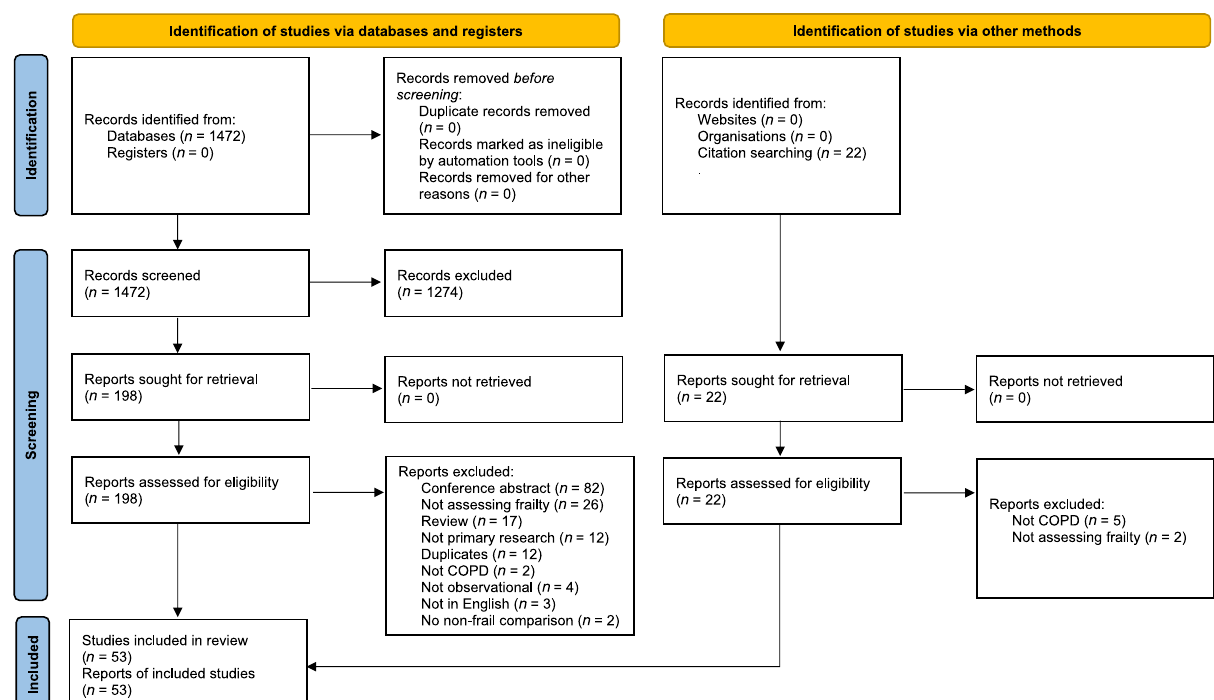
Fig. 1 PRISMA diagram of study identi fi cation and screening. This fi gure summarises the stages of identi fi cation and screening of eligible